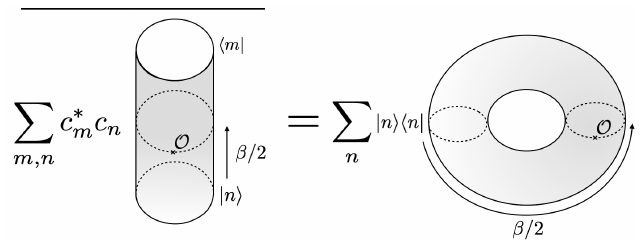
Figure 2 . The geometrical picture of how the canonical TPQ state reproduces the thermal expec- tation values. This has a similar geometrical structure to the bra-ket wormhole in the gravitational path-integral.